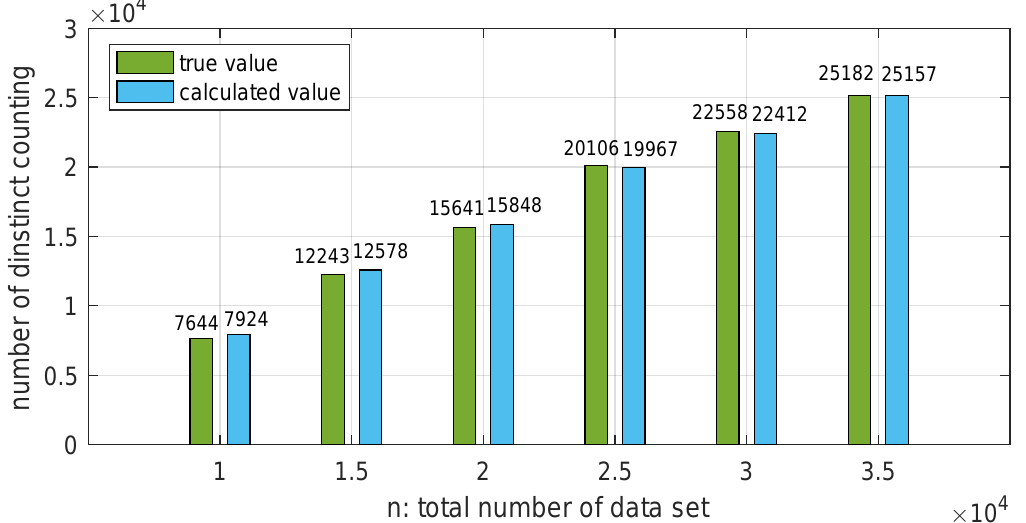
Figure 7. The contrast of the numbers of distinct counting coming from the true value and the calculated